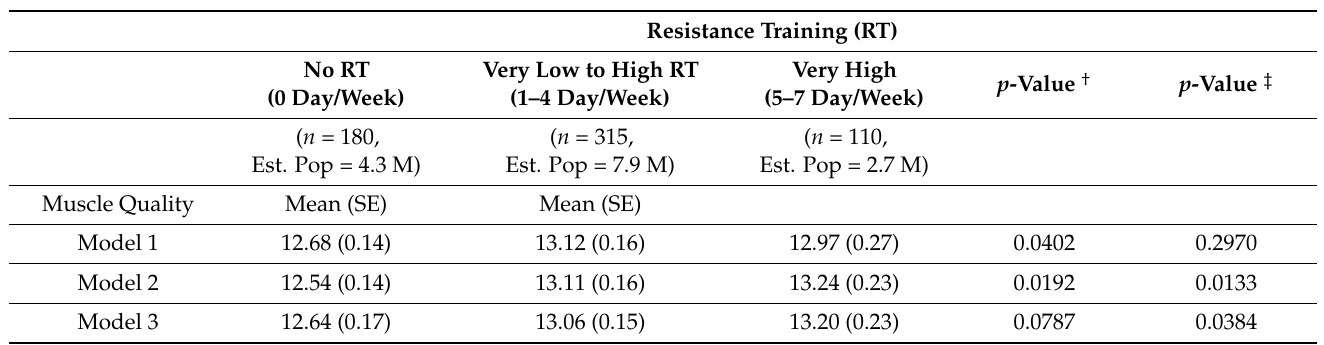
Table 4. Association between resistance training (0 day/week, 1–4 day/week, and 5–7 day/week) and muscle quality (age 12–15 years